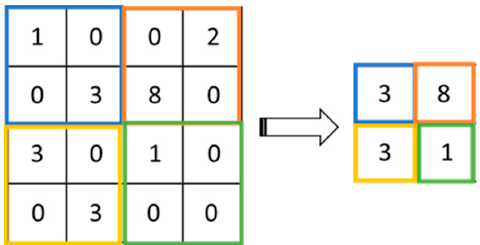
Figure 5. Schematic diagram of max pooling.